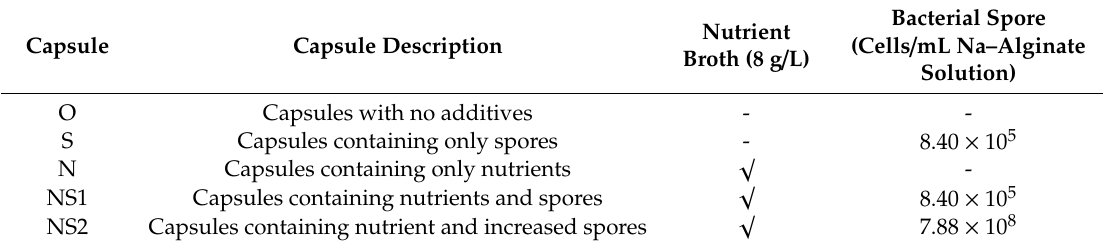
Figure 1. Encapsulation procedure for NS1–CaAlg capsules. Table 1. Composition and description of prepared CaAlg capsules.